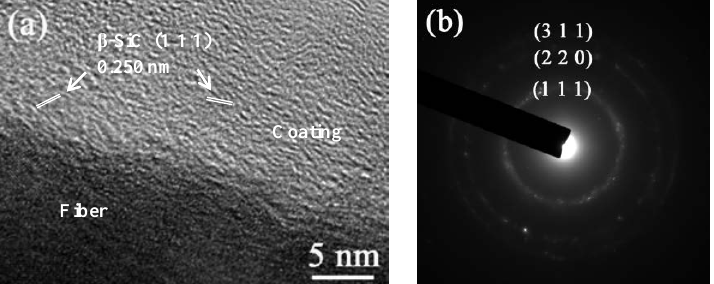
Figure 5. TEM analysis of the fibers with coatings deposited for 2 h: ( a ) HR-TEM image and ( b ) SAED pattern of coatings.